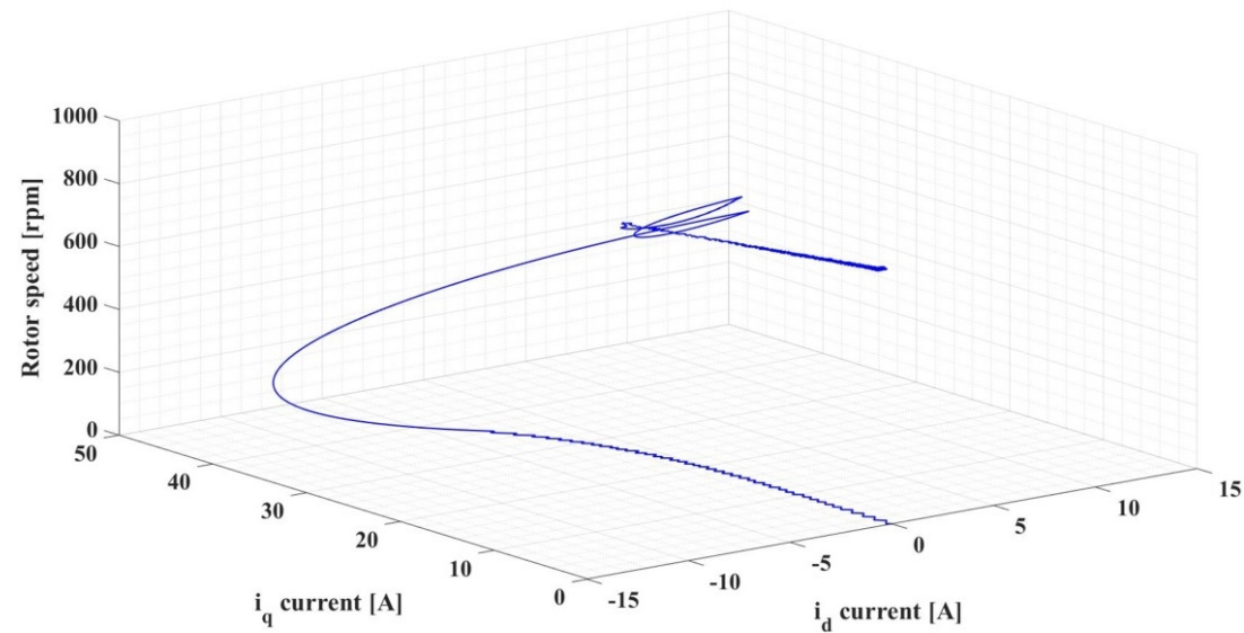
Figure 32. Image of the state space for PMSM variable structure with switching signal type 2: rotor